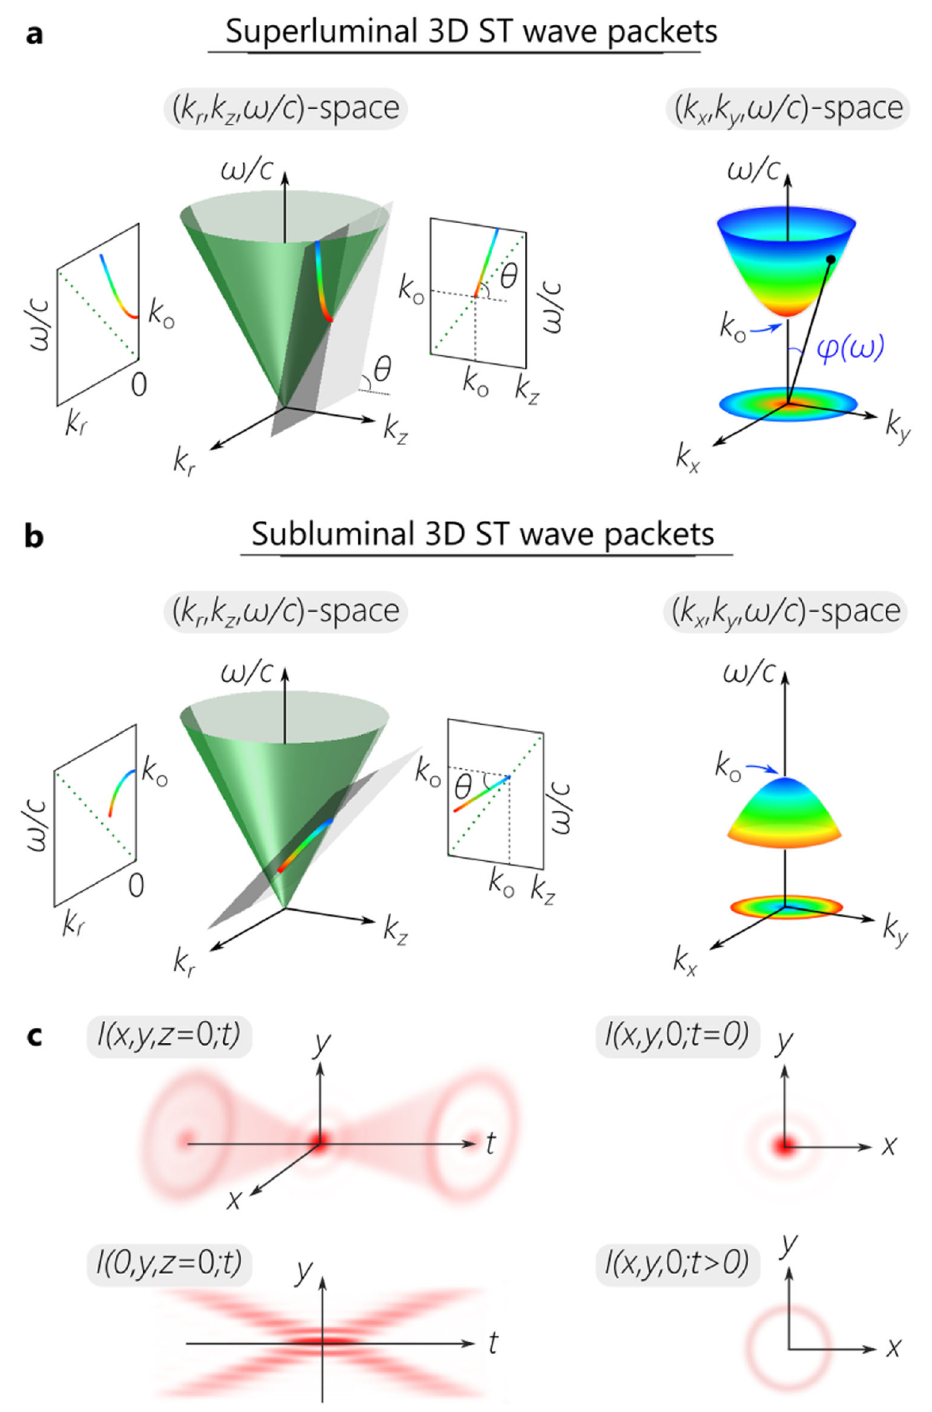
Fig. 1| Visualizationofthespectralsupport domain for 3D ST wavepacketson a forasubluminalSTwavepacketwith θ <45 ∘ ,wherethespectralsupportdomainon the surface of the free-space light-cone. a The spectral support domain for a the light-cone in ð k r , k z , ω c Þ -space is an ellipse. In ð k x , k y , ω c Þ -space, the spectrum is an ellipsoid of revolution (a spheroid, which may be prolate or oblate according to the superluminal 3D ST wave packet at the intersection of the light-cone k 2 r + k 2 z = ð ω c Þ 2 withaspectralplanethatisparalleltothe k r -axisandmakesanangle θ >45 ∘ withthe valueof θ ). c Plotofthespatio-temporalintensitypro fi le I ( x , y , z =0; t )ata fi xedaxial Þ -space the k z -axis. The conic section at the intersection is a hyperbola. In ð k x , k y , ω plane z =0, the intensity pro fi le in a meridional plane I (0, y , z =0; t ), and the trans- c spectrumisonehalfofatwo-sheet hyperboloid (an elliptichyperboloid). b Same as verse pro fi les at the wave-packet center I ( x , y ,0;0) and off-center I ( x , y ,0; t